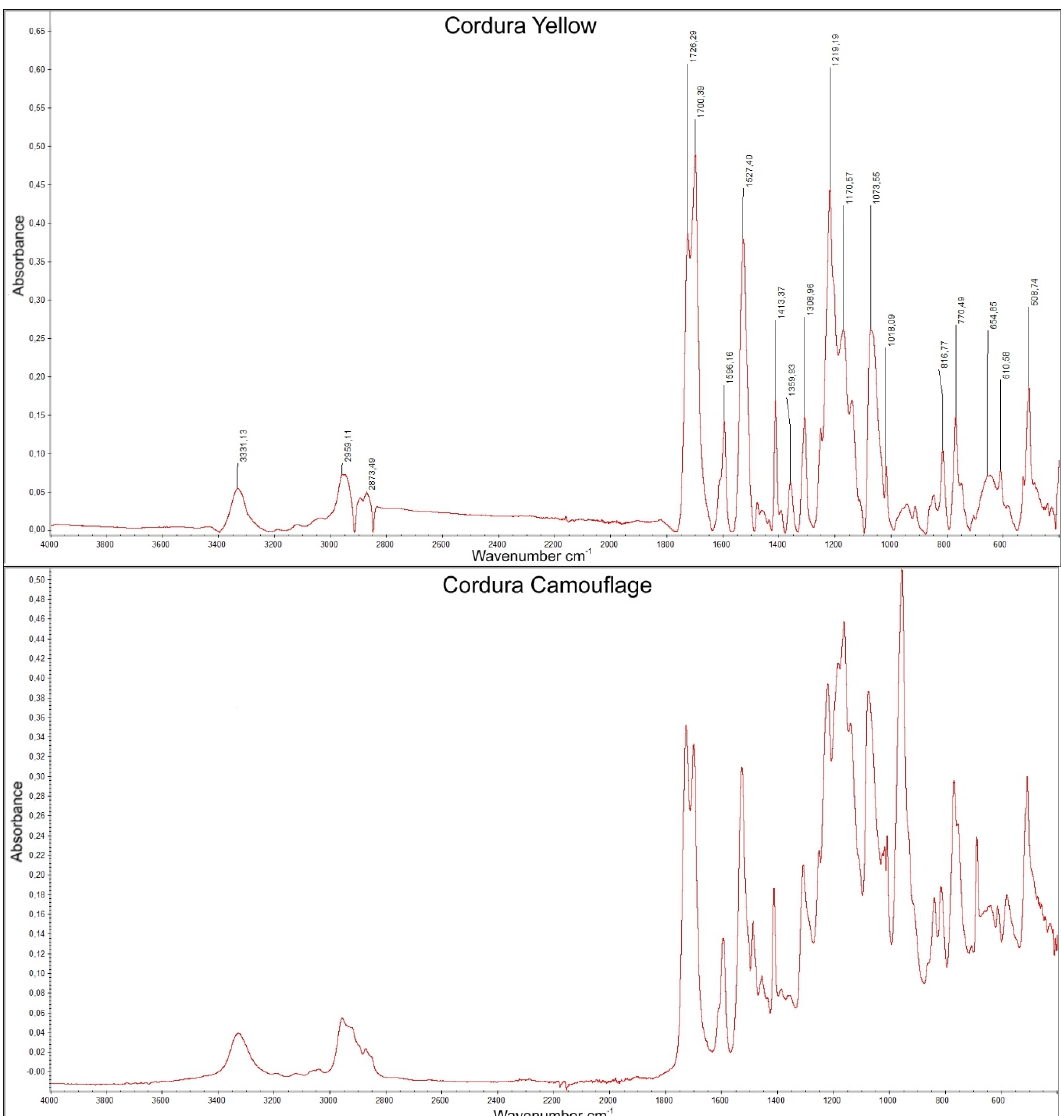
Figure 3. FTIR spectra for Cordura Yellow and Cordura Camouflage.